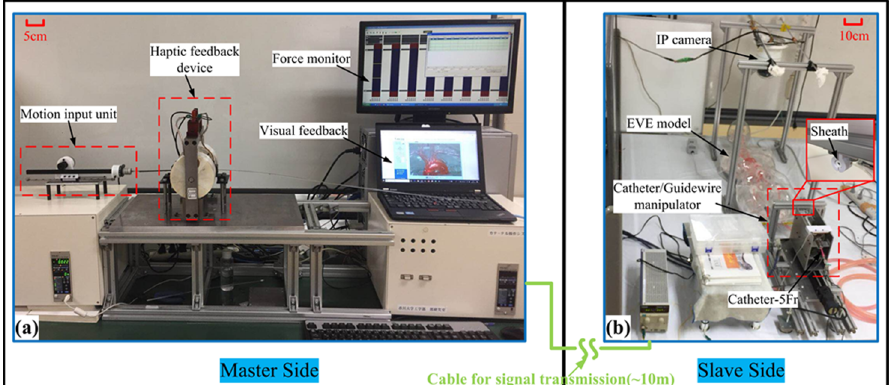
Figure 18. Experimental setup of collision detection performance for the presented system. ( a ) The master side of the presented system. ( b ) The slave side of the presented system.